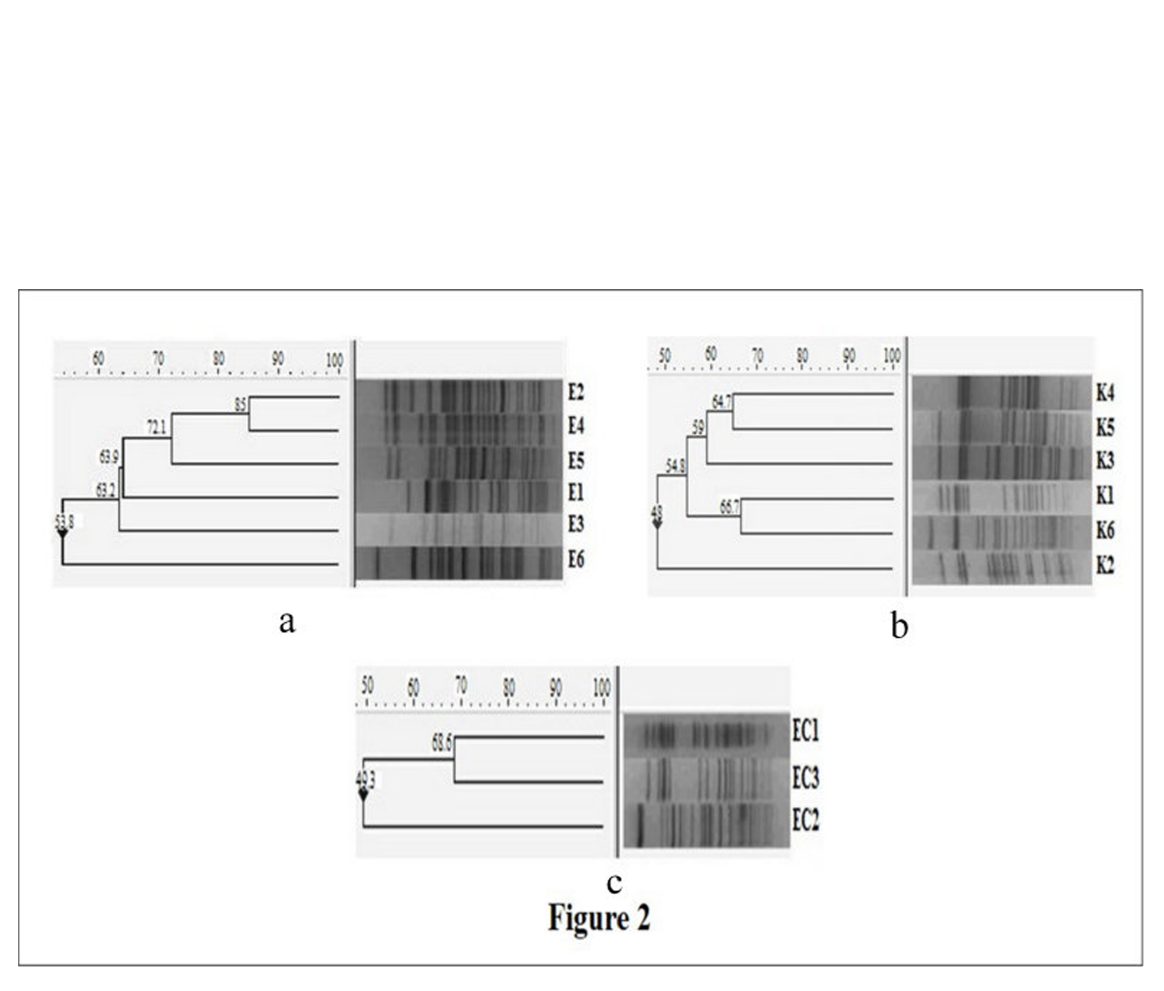
Figure 2. Analysis of the genetic relationship according to Dice’s similarity coefficient and the unweighted pair group method with arithmetic mean (UPGMA) (the position tolerance and optimization were set at 1.0 and 1.0% respectively) of the XbaI patterns of E. coli (E1-E6) (a), K.pneumoniae (K1-K6) (b) and E.cloacae (EC1-EC3) (c). Salmonella serotype Braenderup H9812 has been used as reference standard.